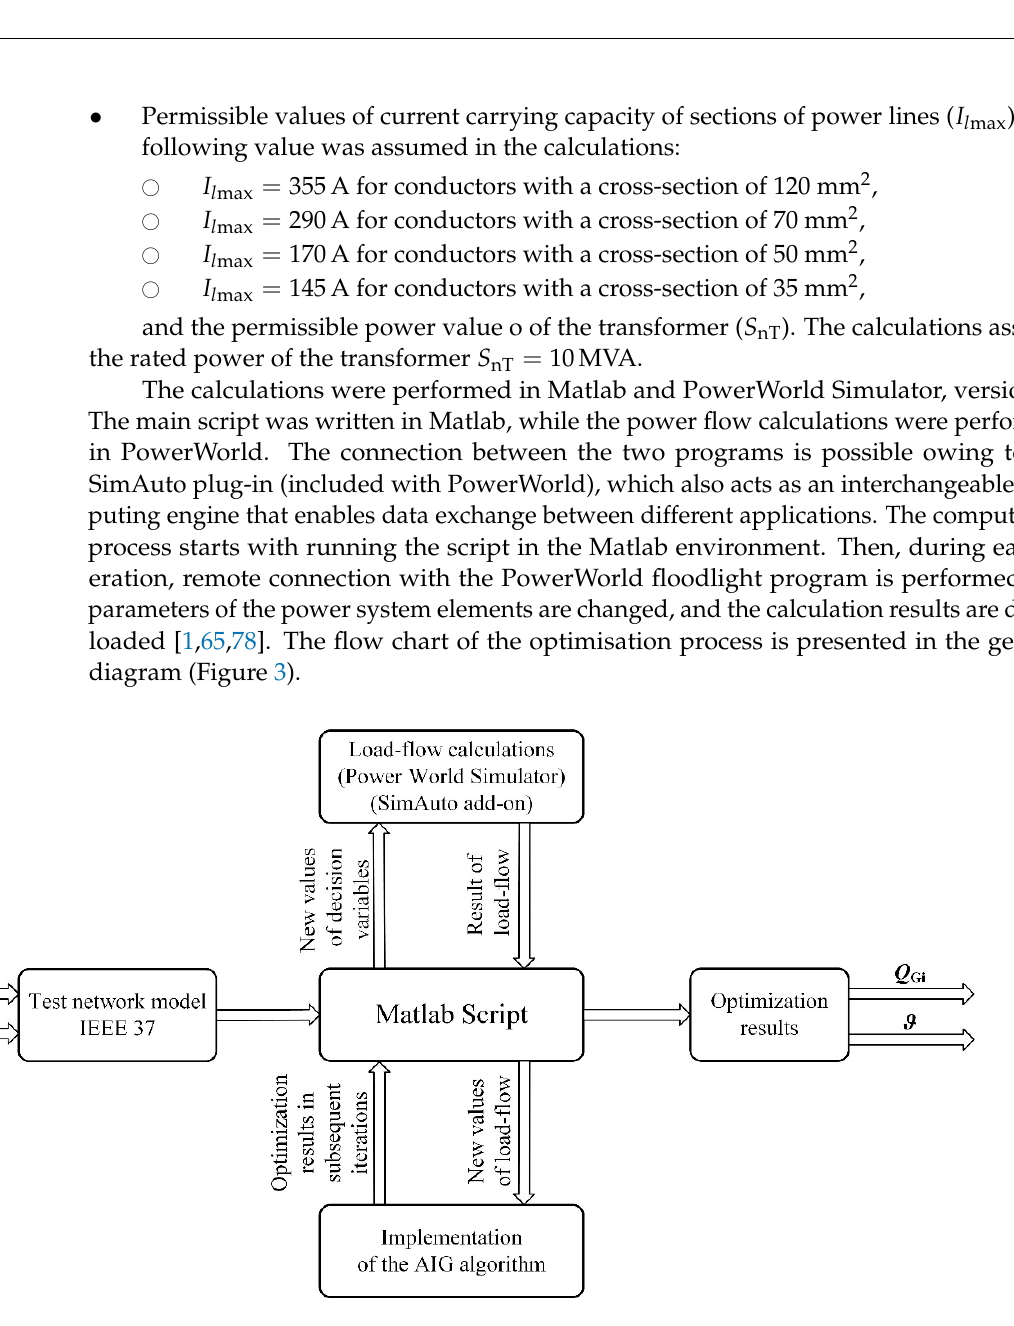
Figure 3. General scheme of the organisation of the computational process used in solving the opti- misation task. optimisation